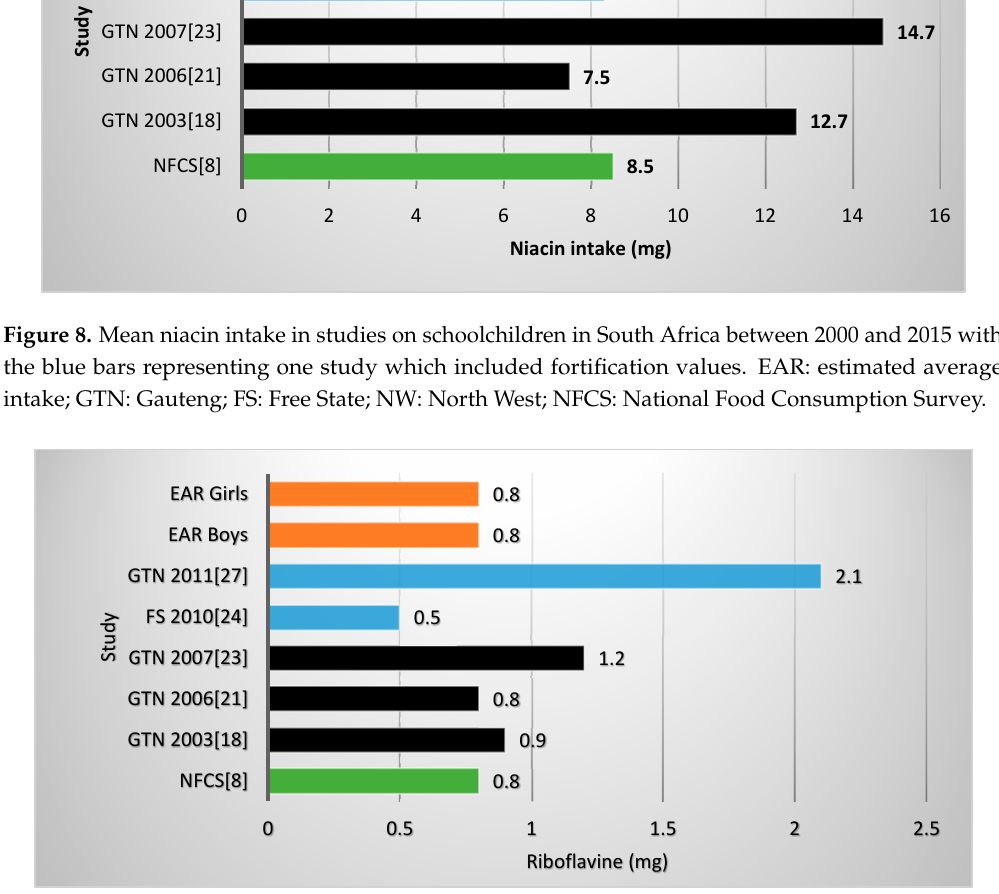
Figure 9. Mean riboflavin intake in studies on schoolchildren in South Africa between 2000 and 2015 with the blue bars representing two studies which included fortification values. EAR: estimated average intake; GTN: Gauteng; FS: Free State; NW: North West; NFCS: National Food Consumption Survey. Table 3. Percentage of schoolchildren who consumed a fortified item on the previous day/days in four studies which reported frequency of consumption in the post-fortification era.